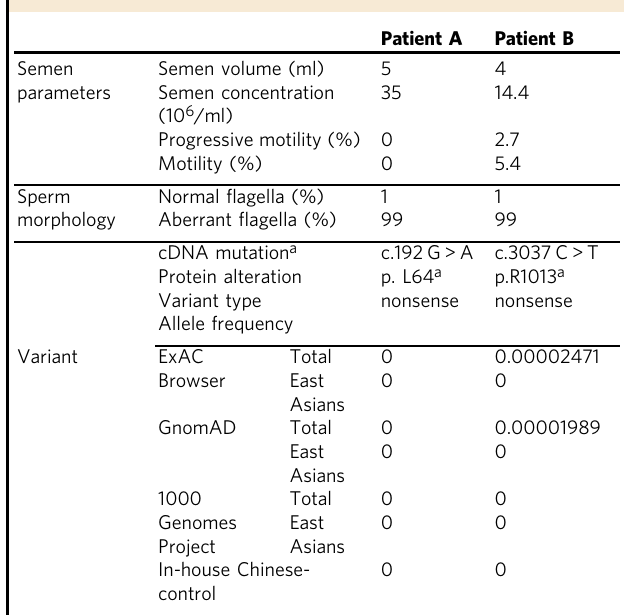
Table 1 Semen and variant analysis in the MMAF patients from consanguineous families